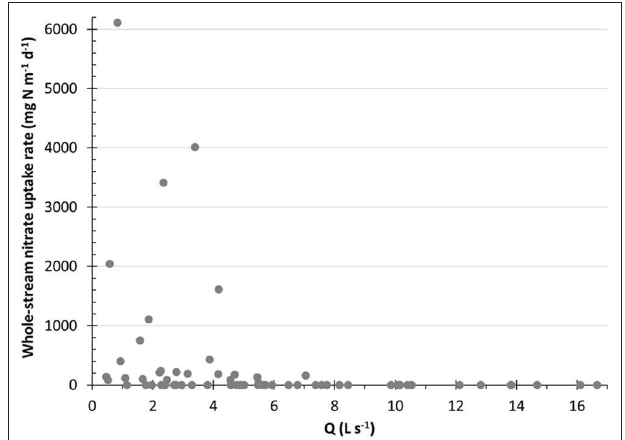
observe measurable whole-reach gross NO − 3 -N uptake during the pulse addition experiments. The entire dataset from pulse addition experiments is